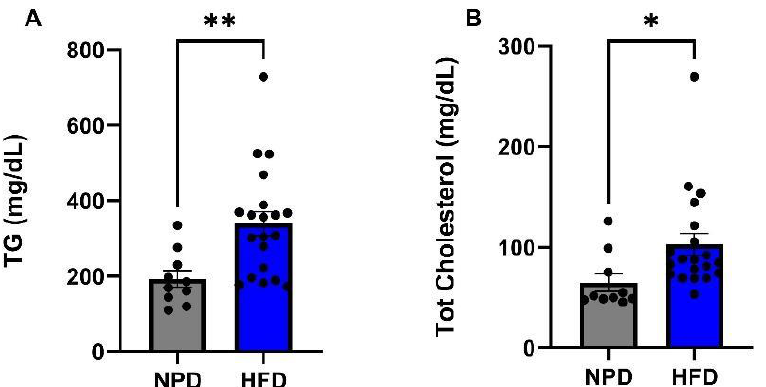
Figure 3. Lipid profile in NPD and HFD experimental groups after 8 weeks (T1) of HFD. ( A ) Triglycerides (TG). Plasma TG levels (mg/dL) differences between NPD and HFD groups after 8 weeks of HFD. ( B ) Total cholesterol. Plasma total cholesterol levels (mg/dL) differences between NPD and HFD groups after 8 weeks of HFD. Statistical significance indicated for (*) p < 0.05 and (**) p < 0.01.